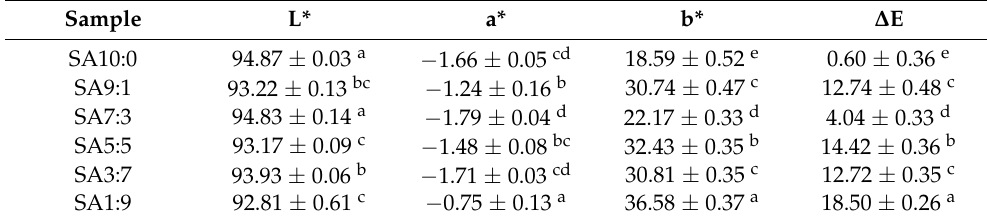
Table 3. The color of sodium caseinate-acetylated mung bean starch–lutein microcapsules.